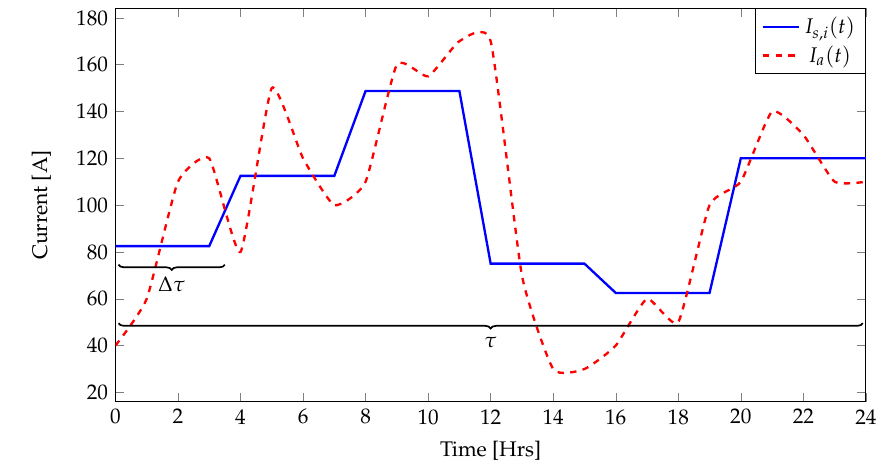
Figure 15. Step function construction of a wind-based load